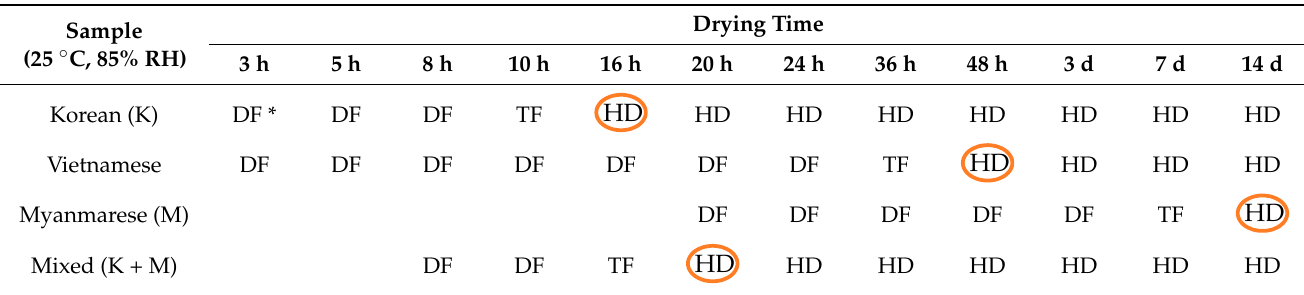
Table 2. Drying time of Oriental lacquer tree saps. Sample